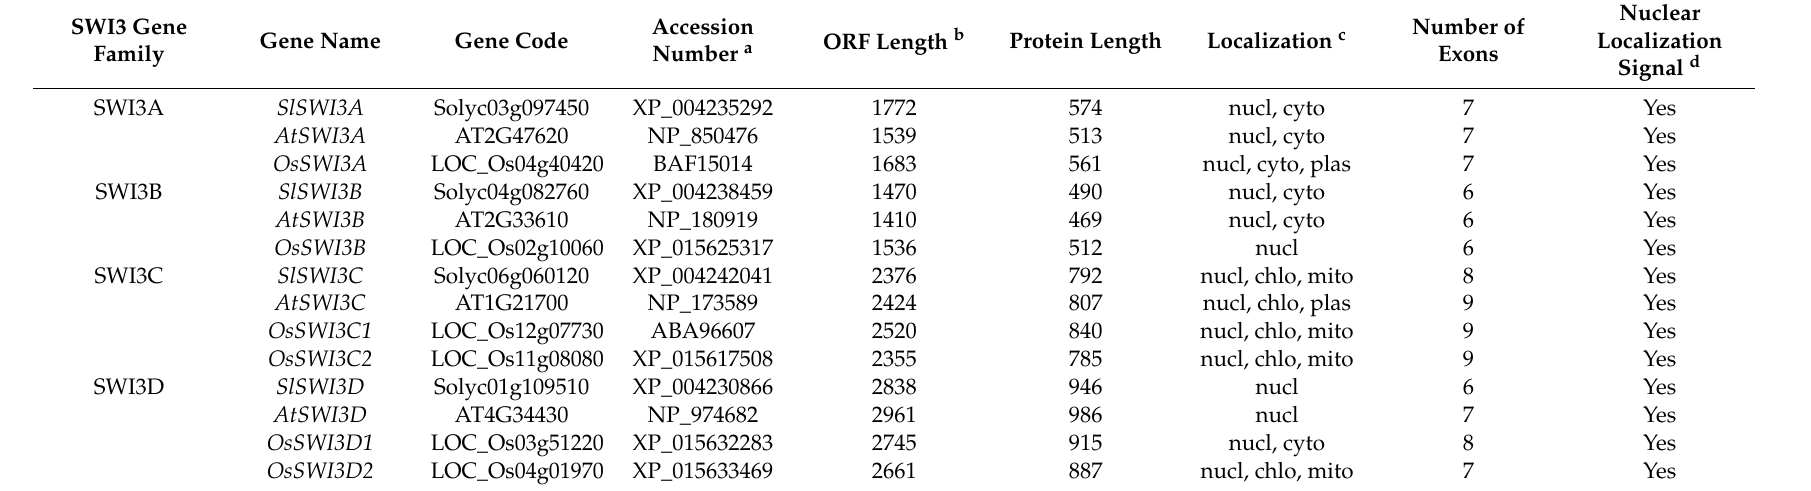
Table 1. The SWI3-like proteins in Tomato, Arabidopsis and